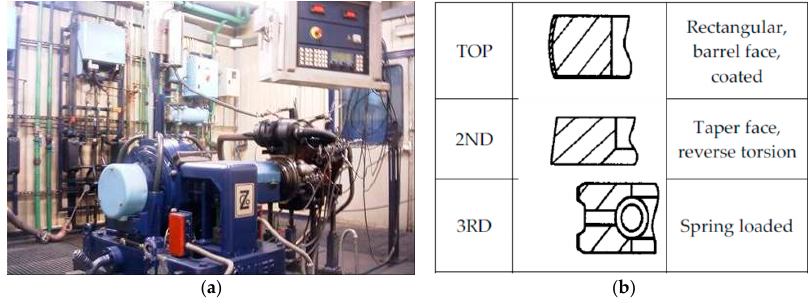
Figure 7. ( a ) The engine arrangement in the test bed [19]. ( b ) The piston ring set is composed of three units - two compression units and one oil control unit.